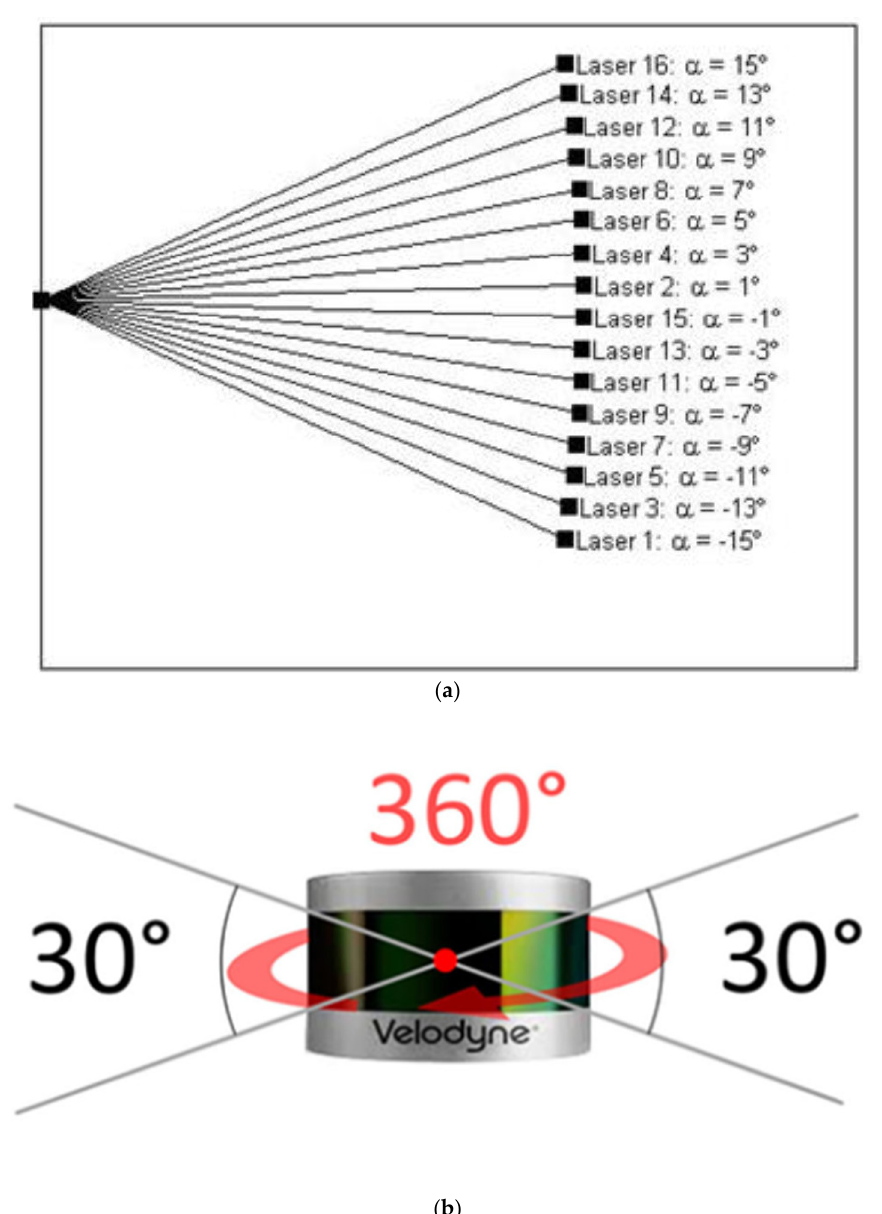
Figure 1. Velodyne VLP-16 sensor. ( a ) Internal laser positions [13]; ( b ) Sideview [14].